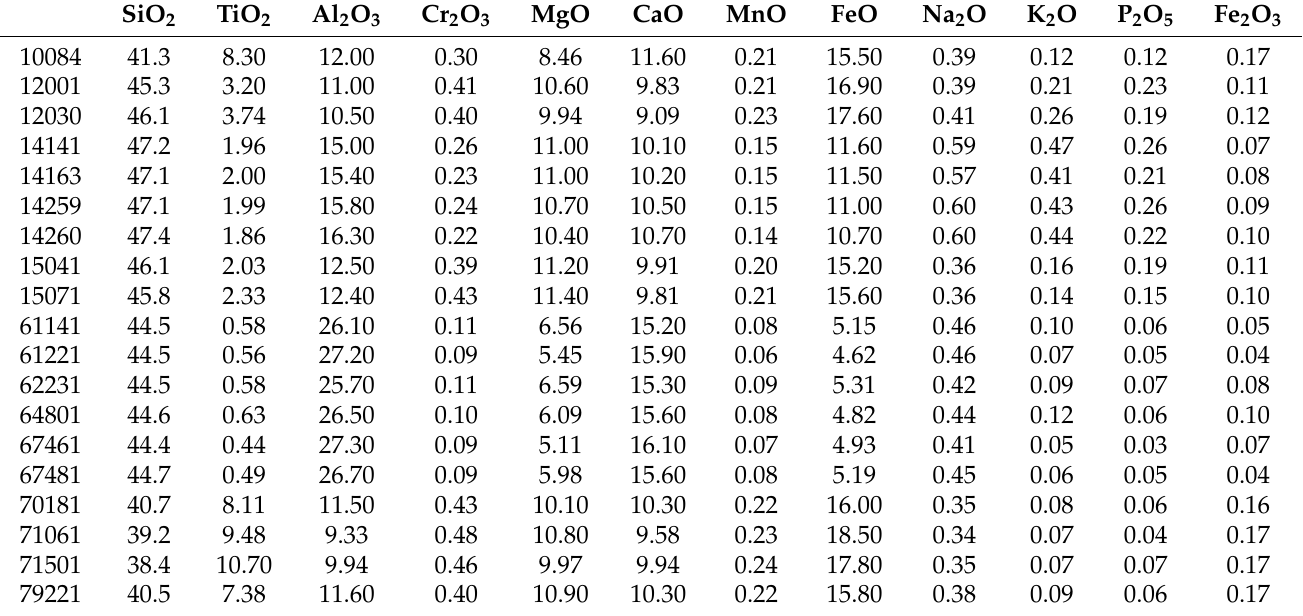
Table A9. Elemental abundances used for the LSCC samples taken from Taylor et al. [18] and Taylor et al. [19]. The elemental and mineral abundances of the 20–45 µ m size fraction were used for the priors, but the 0–45 µ m size fraction spectra were used for the unmixing. The 0–45 µ m size fraction mineral abundances were not